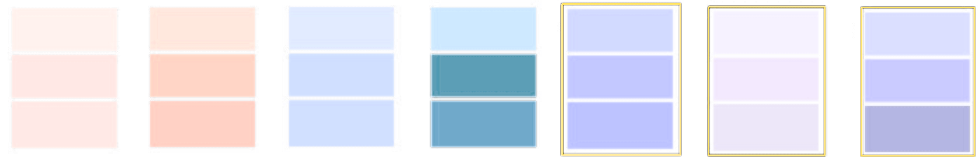
Figure 13. Examples of colour comparisons using pseudo-inverse